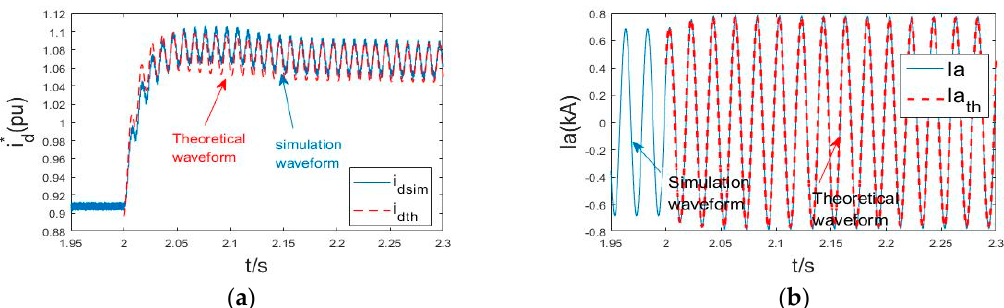
Figure 15. ( a ) Waveform of d -axis output current in phase to phase short circuit fault. ( b ) Waveform of